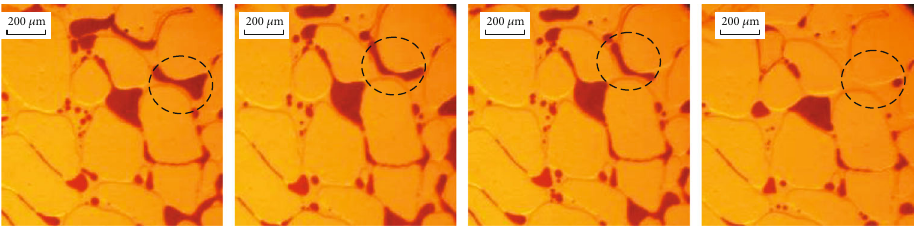
Figure 16: Schematic diagram of the displacement process of blind end residual oil (oil in pores is indicated by the red